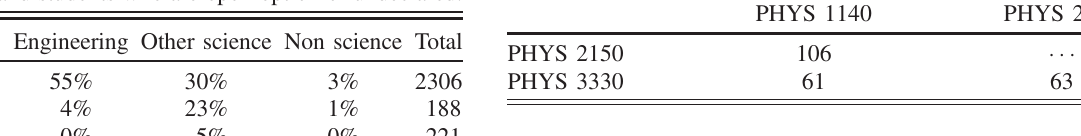
TABLE I. Breakdown of majors in each of CU ’ s three required TABLE II. Number of students in each of the three partially